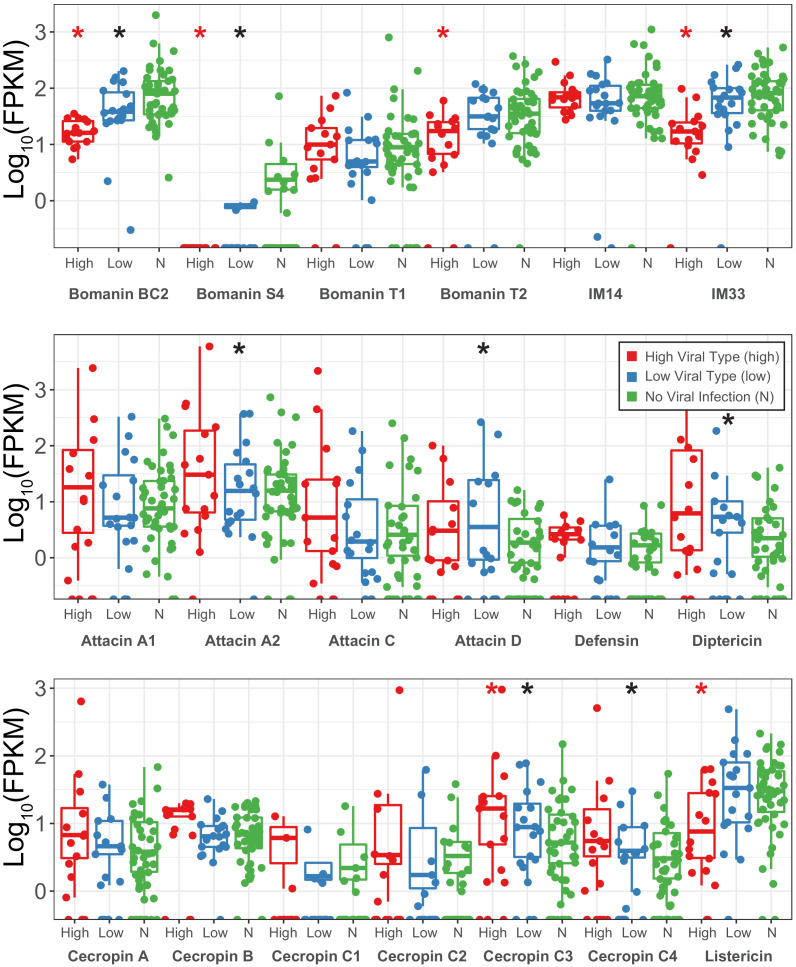
Expression changes (shown as transcript fragments per 1 million reads per 1kbp of exon) of antimicrobial peptides between strains infected with High type DiNV, Low type DiNV or not infected.Black stars above low samples show significant differential expression between DiNV-infected strains and uninfected strains (multiple testing corrected p-value<0.05). Red stars above high samples show significant differential expression between Low type infected strains and high type infected strains (multiple testing corrected p-value<0.05).